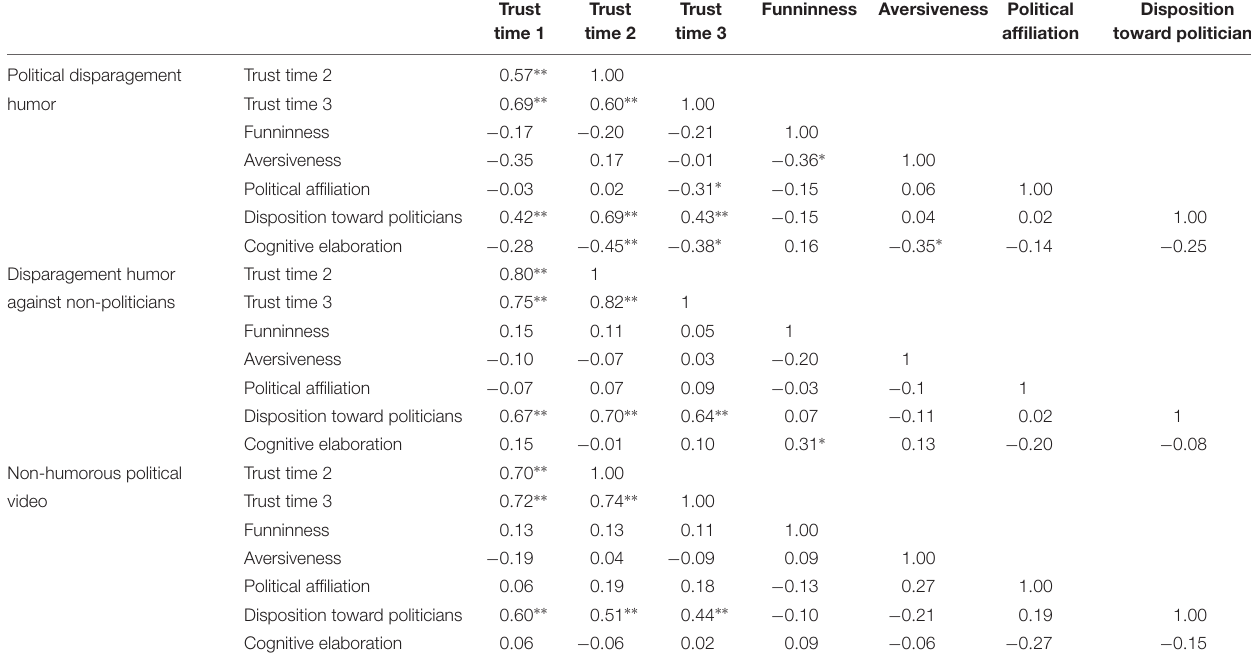
TABLE 4 | Correlations between considered